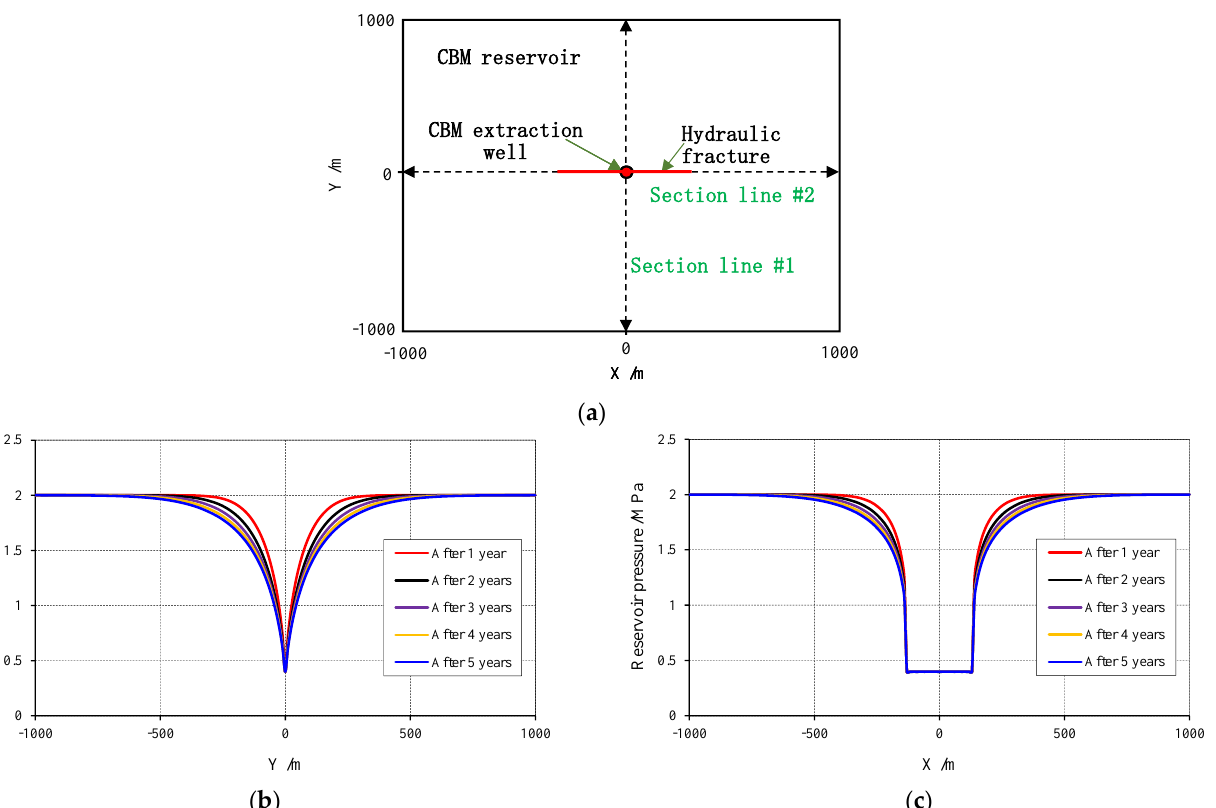
Figure 7. The reservoir pressure on the profile lines after mining for different years. ( a ) profile lines for analyzing ( b ) profile line 1 and ( c ) profile line 2.